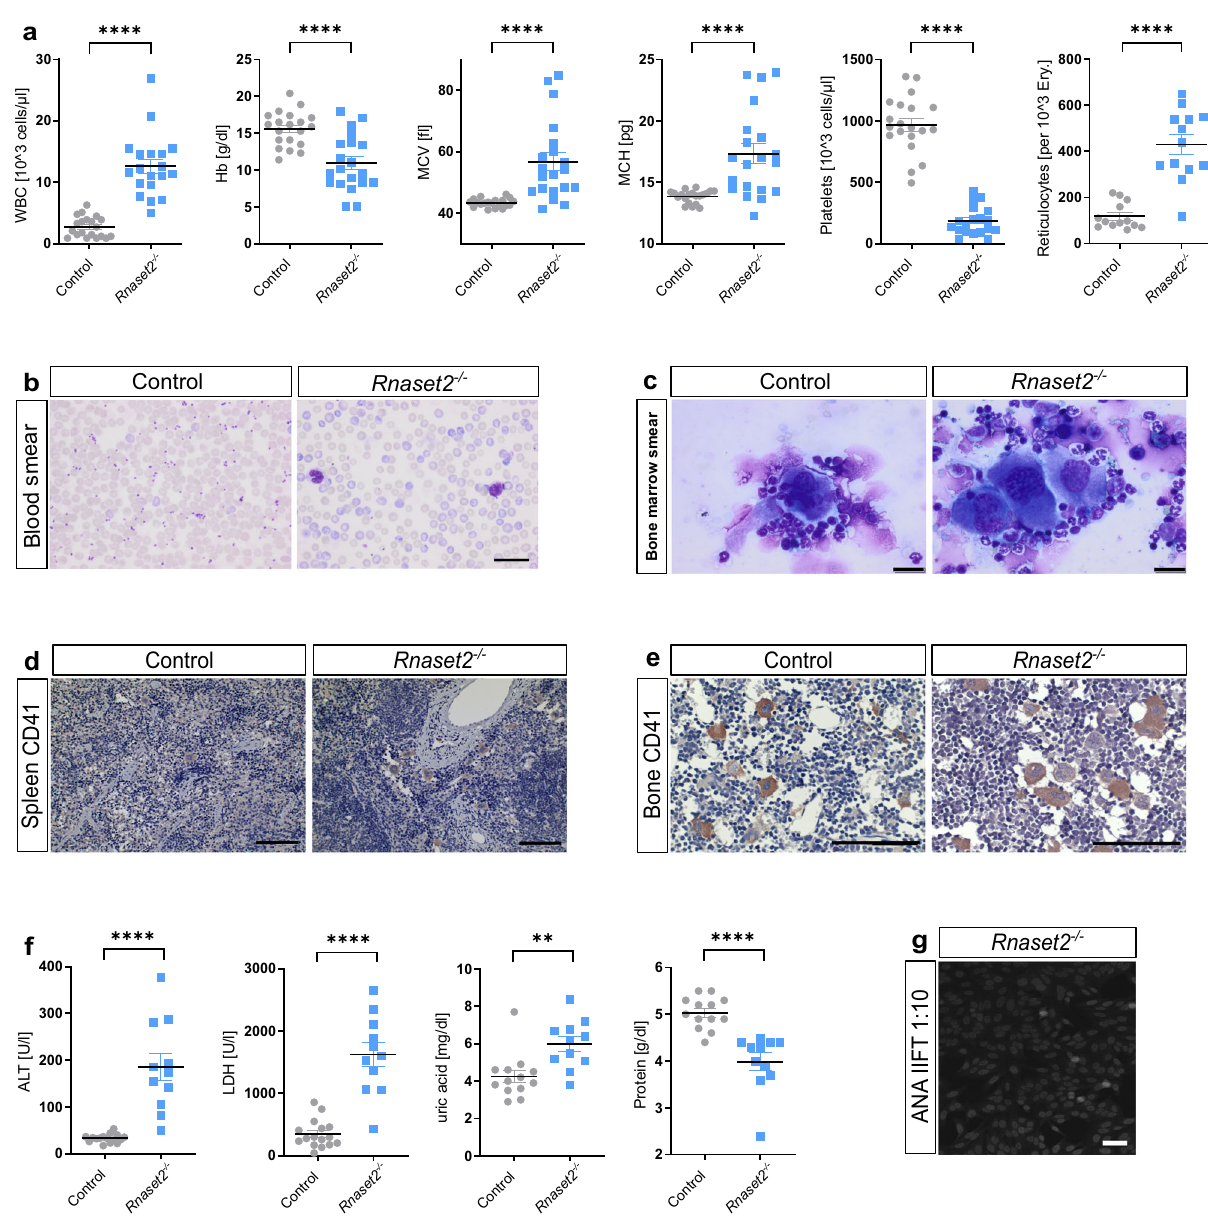
Fig. 3 Disturbed hematopoiesis and anti-nuclear antibody detection. a Blood counts from EDTA-stabilized whole blood of Rnaset2 − / − and control mice revealed increased numbers of white blood cells (WBC, n = 19 Rnaset2 − / − and n = 20 control animals) and reticulocytes ( n = 13 Rnaset2 − / − and control animals, respectively) in Rnaset2 − / − mice accompanied by highly signi fi cantly reduced platelets ( n = 19 Rnaset2 − / − and n = 20 control animals) and hemoglobin (Hb) levels ( n = 20 Rnaset2 − / − and control animals, respectively). The mean corpuscular volume (MCV) and mean corpuscular hemoglobin (MCH) were signi fi cantly elevated ( n = 20 Rnaset2 − / − and control animals, respectively). Data depicted as the mean ± SEM. p values of two-tailed Student ’ s t -test are represented as **** p < 0.0001. b Blood smears of Rnaset2 − / − and control mice clearly demonstrated the severe thrombocytopenia and the massive reticulocytosis (purple cells) in three biological replicates for control and Rnaset2 − / − , respectively. Scale bar, 25 µ m. c Bone marrow smear and immunohistochemical staining of d spleen and e bone marrow showed a higher density of CD41 + megakaryocytes, which presented dysplastic features demonstrated by single, small, and round nuclei and megakaryocyte agglomerations. Spleen and bone marrow images are representative of three independent experiments, scale bar, 100 µ m. Bone marrow smear images are representative of four biological replicates for control and Rnaset2 − / − , respectively, scale bar, 20 µ m. f Depicted values of clinical chemistry from serum samples of Rnaset2 − / − ( n = 11 animals) and control ( n = 16 animals for ALT and LDH and n = 13 for uric acid and protein) mice were signi fi cantly altered, whereas further parameters measured remained unremarkable. Data depicted as the mean ± SEM. p values of two-tailed Student ’ s t -test are represented as ** p = 0.0027, **** p < 0.0001. ALT alanine aminotransferase, LDH lactate dehydrogenase. g Representative fl uorescence microscopy image with a positive antinuclear antibody (ANA) indirect immuno fl uorescence test (IIFT) of Rnaset2 − / − mouse serum (12 weeks old) with a titre of 1:10. Further titration even revealed a titre of 1:1000 for autoantibodies present in this serum. Scale bar, 50 µ m. p values are represented as **** p < 0.0001, *** p < 0.001, ** p < 0.01, * p < 0.05 and not signi fi cant p ≥ 0.05. Source data are provided as a Source data fi